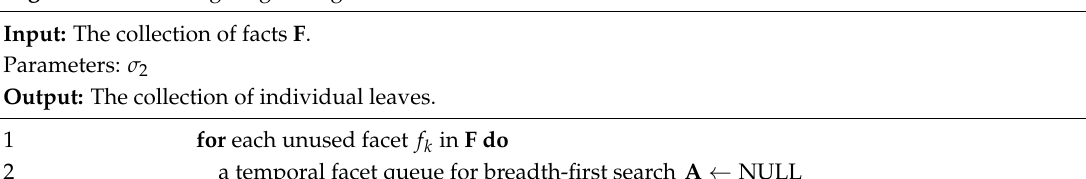
“2” into the region (Figure 3b). Finally, after 4 rounds of growing, the total structure now covers 9 small facets that are assigned the same red color (Figure 3e). The pseudocode for facet region growing is listed in Algorithm 3. Algorithm 3 Facet region growing.